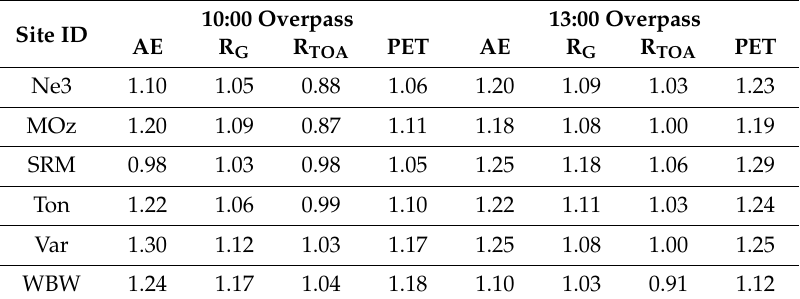
Table A2. Mean ET RMSE in mm per day between a 2, 4, 8 or 16-day revisit scenario and the